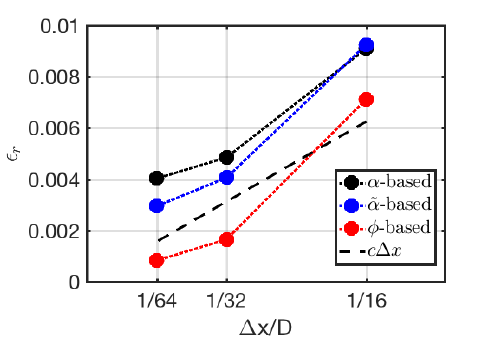
Figure 6. Numerical error corresponding to the three curvature estimation methods as a function of grid resolution for the problem of a 3D oscillating droplet.